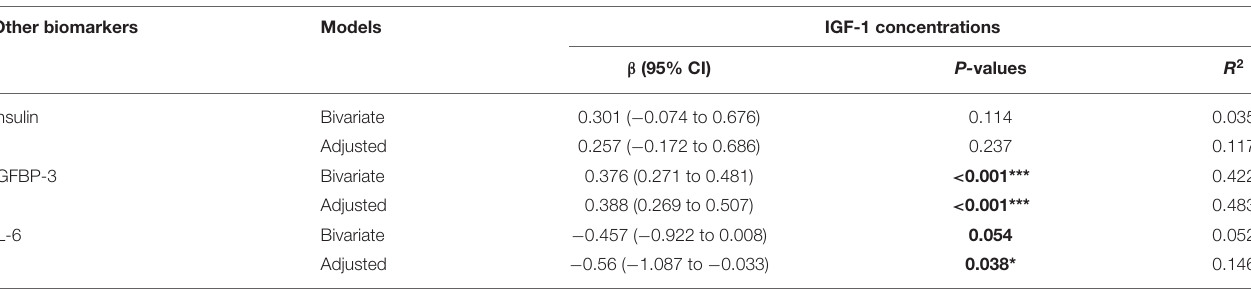
TABLE 4 | Associations between IGF-1 concentrations and other